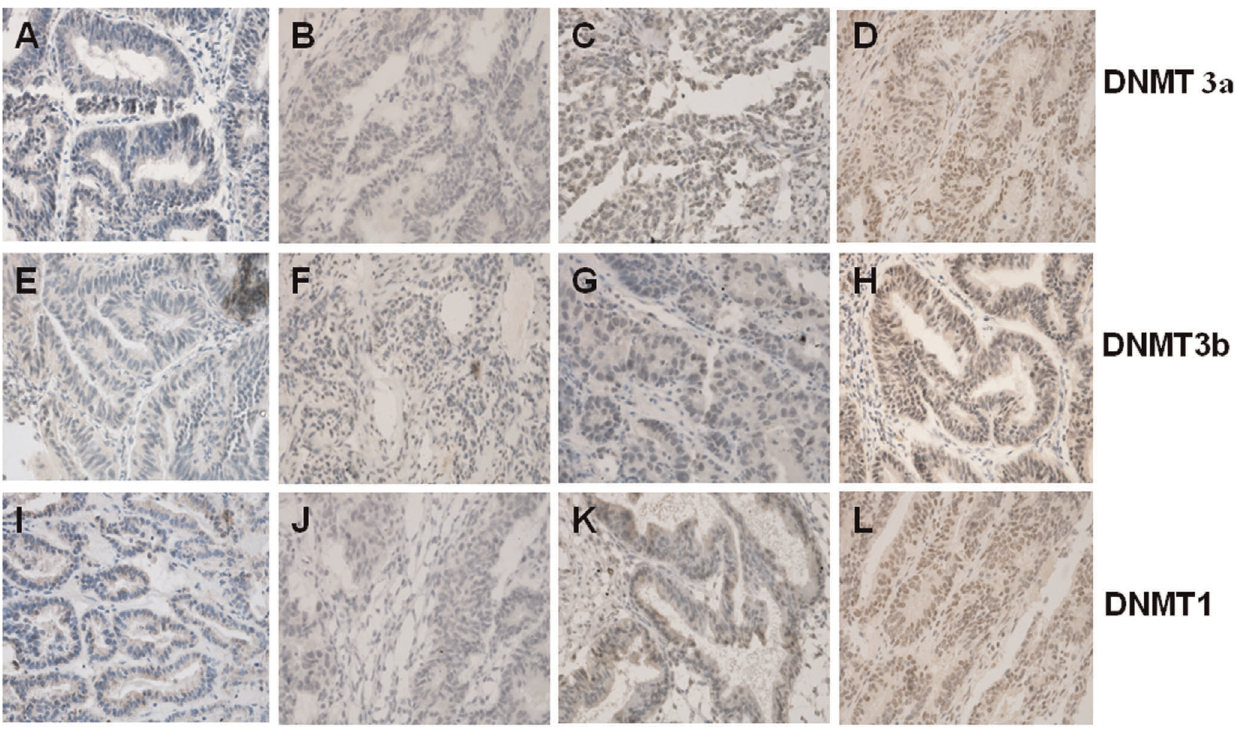
Figure 2. Immunohistochemical staining of DNMT3a, DNMT3b, and DNMT1 proteins in benign ovarian tumors. Representative examples of negative (A, E, I), weakly positive (B, F, J), moderately positive(C, G, K), and strong positive (D, H, L) immunostaining for DNMT3a, DNMT3b, and DNMT1 expression are shown, respectively. Magnification: 6 400.